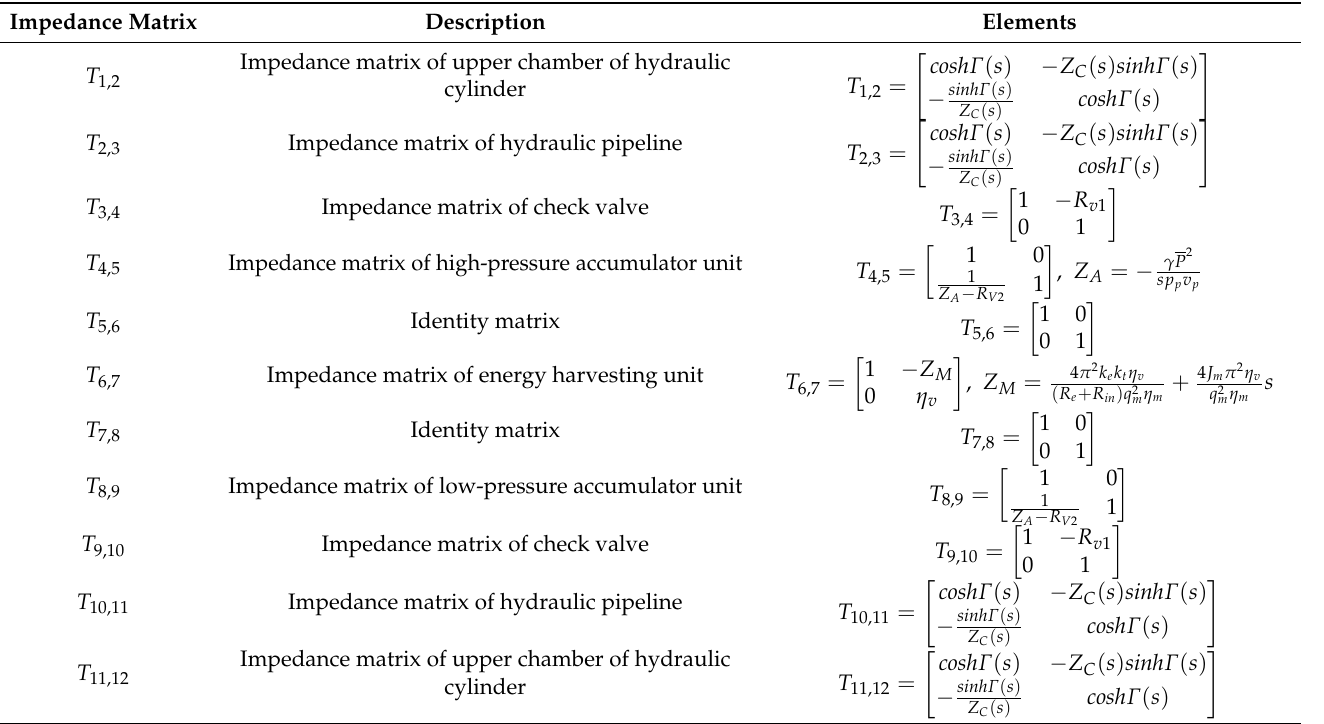
Table 2. The elements of impedance